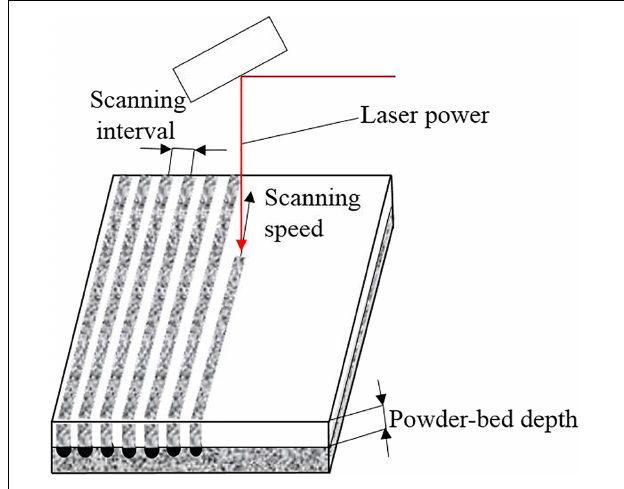
FIGURE 7 | Key process parameters affecting metal crowns quality in SLM.